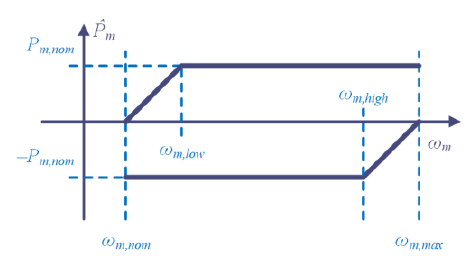
Figure 5. M/G power limitation occurring at ready operating mode.